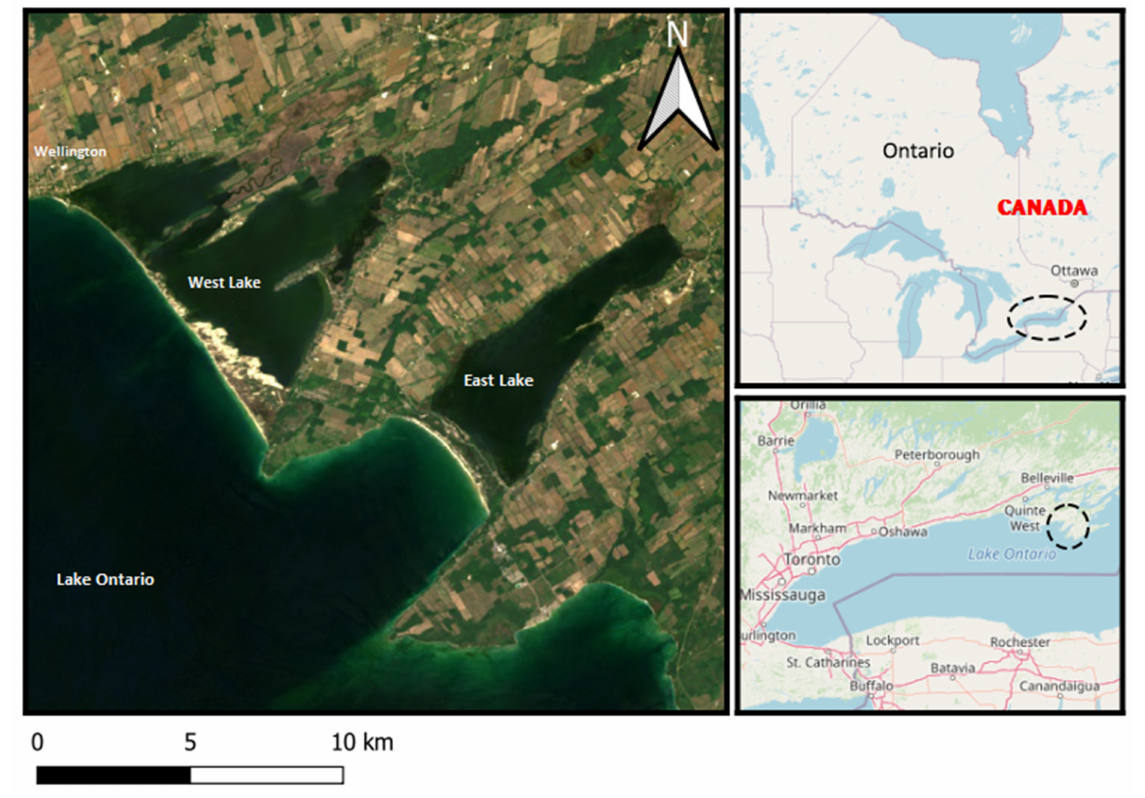
Figure 1. Location of the study area in Prince Edward County, Northeast Lake Ontario,